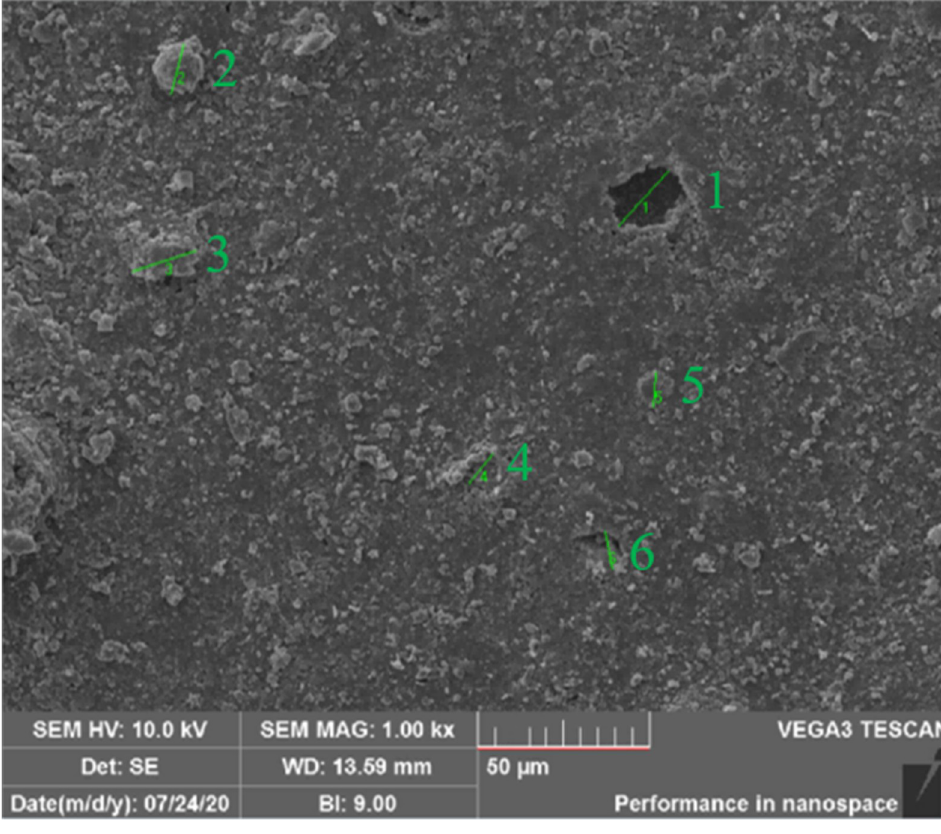
Fig 5. SEM image of RTV